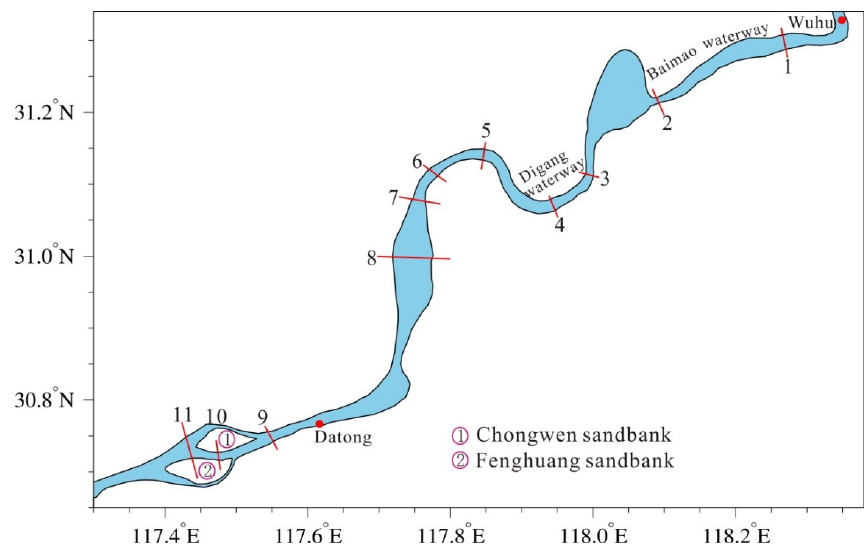
Figure 10. Tidal level limits under various guarantee rates of river discharge in the Changjiang River’s estuary in the flood season. The locations of sections 1–11 are the tidal current limits corresponding to the guarantee rates of 5–95% of river discharge.